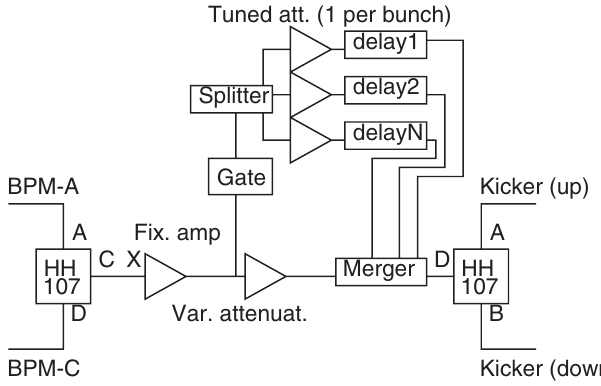
(cid:5) 1 for the GLC with a crossing angle of g (cid:5) 0 : 2 and g b (cid:5) 18 for CLIC at the same 7 mrad, g (cid:5) 0 : 05 and g b crossing angle. With a crossing angle of 10 mrad these (cid:5) 0 : 16 (GLC) and g (cid:5) values become g (cid:5) 0 : 5 =g b (cid:5) 11 : 25 (CLIC). These values have been obtained 0 : 05 =g b